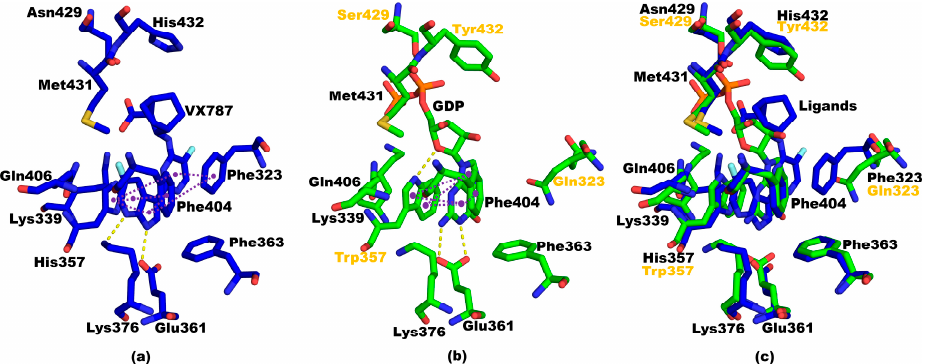
Figure 9. ( a ) PB2cap from A/Victoria/3/1975 (H3N2) bound to VX-787 (PDB code: 4P1U) (blue) [14]. ( b ) PB2cap from B/Jiangxi/BV/2006 PB2cap bound to GDP (PDB code: 4Q46) (green) [15]. ( c ) 4P1U superposed with 4Q46. Gold labelled residues represent 4Q46 differences relative to 4P1U. Hydrogen bonds are labelled with yellow dotted lines, and π - π force interactions are labelled with purple dotted lines [10,23,25].